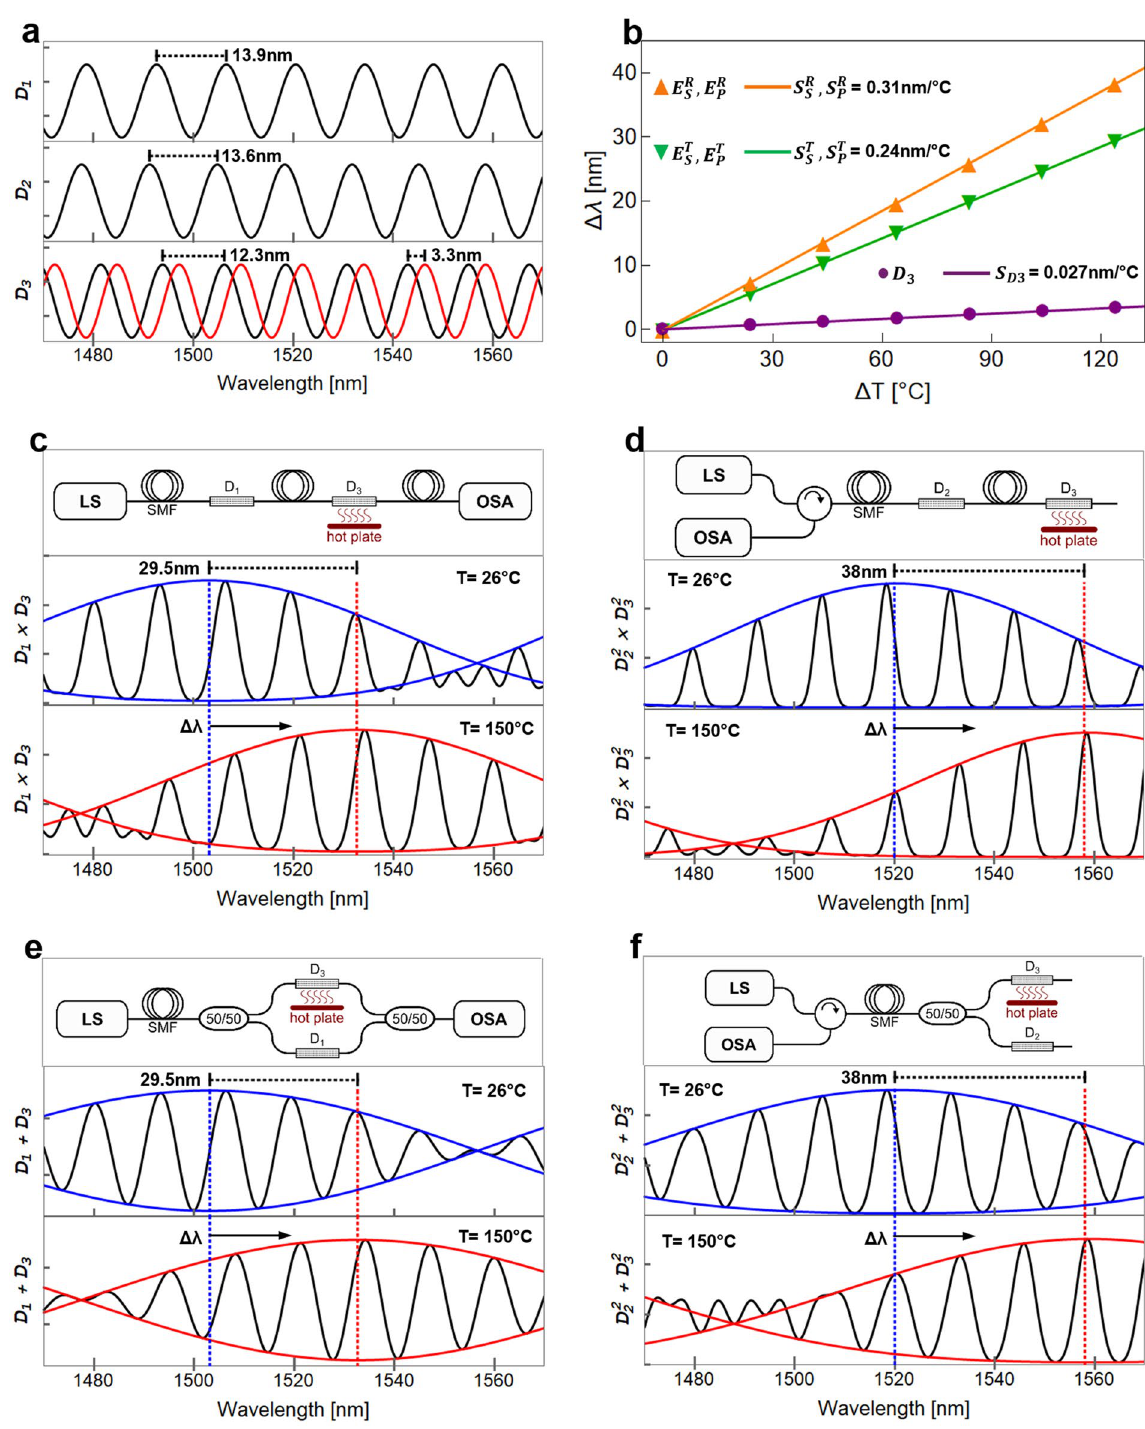
Figure 1. ( a ) Simulated spectral response at room temperature (26 °C) of SCFs with different lengths (solid black lines) and spectral response of device D 3 at 150 °C (solid red line), ( b ) Simulated spectral shift as a function of the applied temperature for device D 3 and also for the different Vernier configurations, ( c )–( f ) Vernier configurations and their simulated spectral responses at room temperature (26 °C) and heated at 150